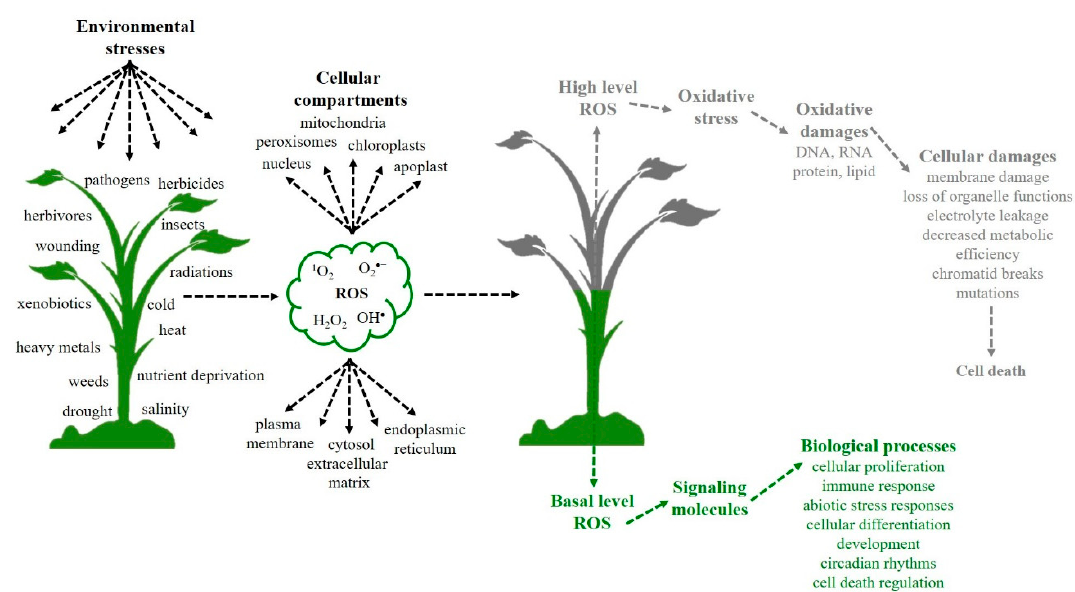
Figure 1. Environmental stressors that can lead to increased generation of reactive oxygen species (ROS) in different cell compartments and the biological consequences. Environmental stressors result in ROS production in different cellular compartments. High-level ROS production results in oxidative stress, oxidative and cellular damages, and even cell death. The basal level of ROS production serves as a signaling molecule and may be involved in various important biological processes.